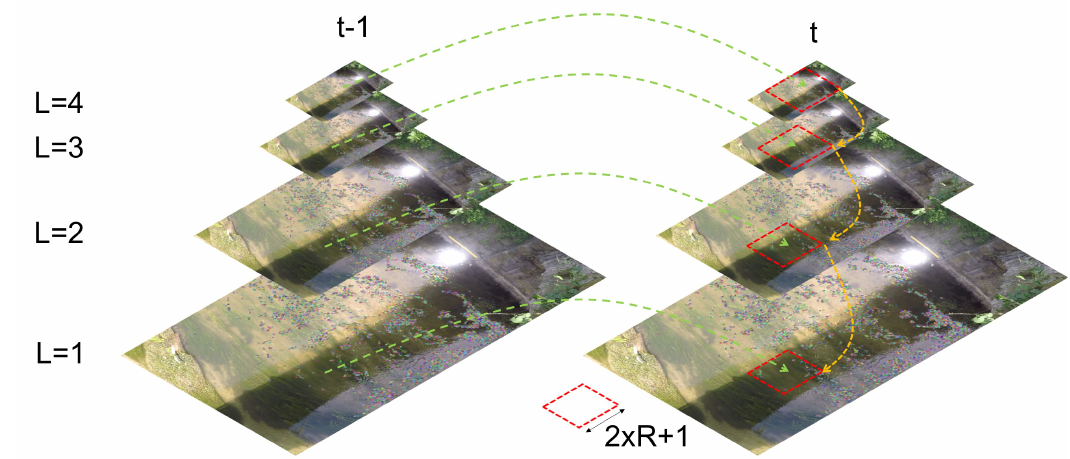
Figure 4. Overview of the tracking strategy used by the OTV algorithm. The FAST features extracted from the input images are used to identify corresponding points across two adjacent frames I t − 1 and I t , employing the Lucas-Kanade algorithm. At each pyramid level L , the corresponding point is searched within an area of radius R